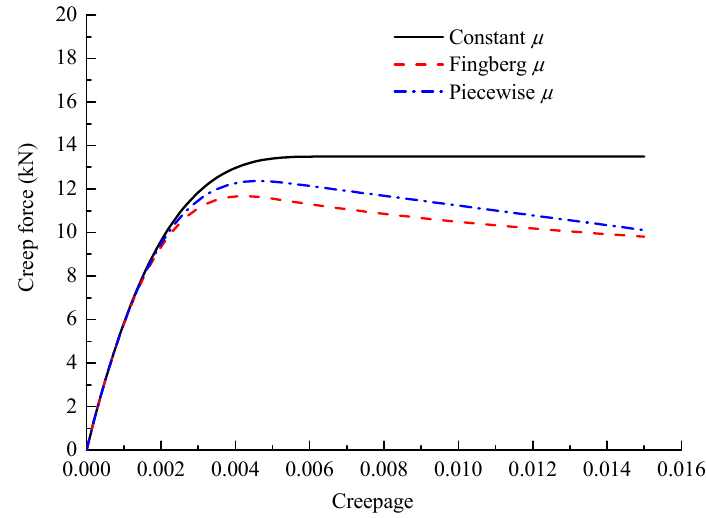
Figure 2. Creep force-Creepage relationship based on three kinds of friction coefficients.